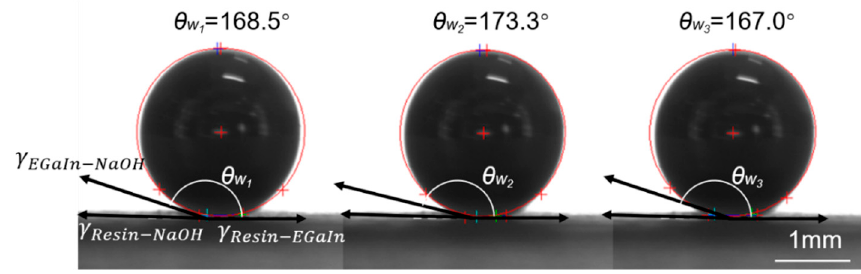
Figure 4. Three measurement results of the contact angle in 0.5 mol/L NaOH solution. Based on the geometric structure of Figure 1a, rounded corners R 1 (at left) and R 2 (at right) are then added to modify the geometric model. The modified model is